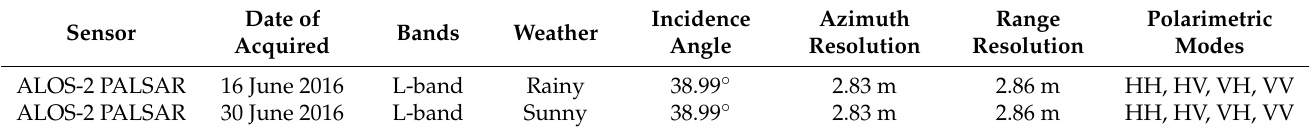
Table 1. Information of qual-polarimetric SAR